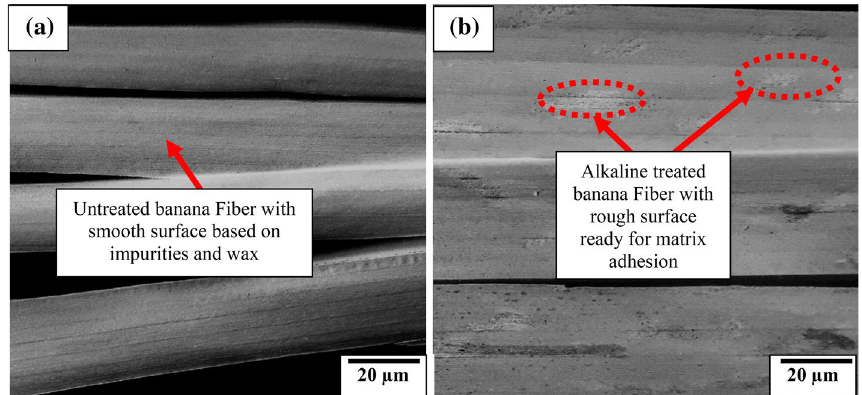
Figure 3. SEM Image of ( a ) untreated and ( b ) 1 M NaOH treated banana fiber.